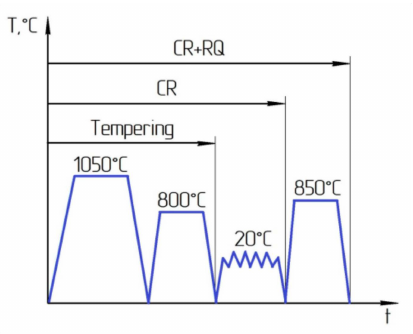
Figure 1. Schematic illustration for heat treatment processes applied to the steel